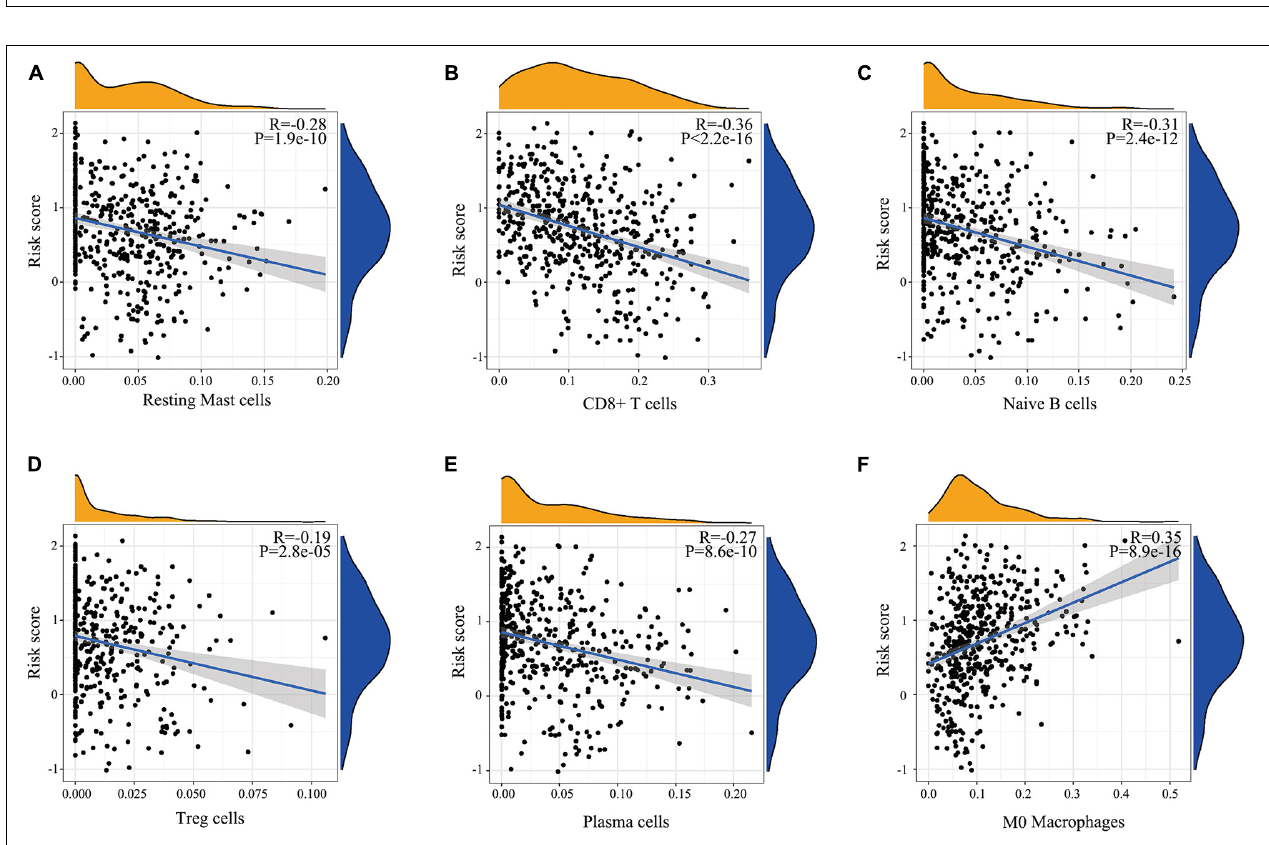
FIGURE 5 | Relationship determined by Pearson correlation analysis between IRGPs and infiltration relative abundances of immune cells. (A) Resting mast cells, (B) CD8 + T cells, (C) Naïve B cells, (D) Treg cells, (E) T follicular helper cells, (F) Plasma cells.